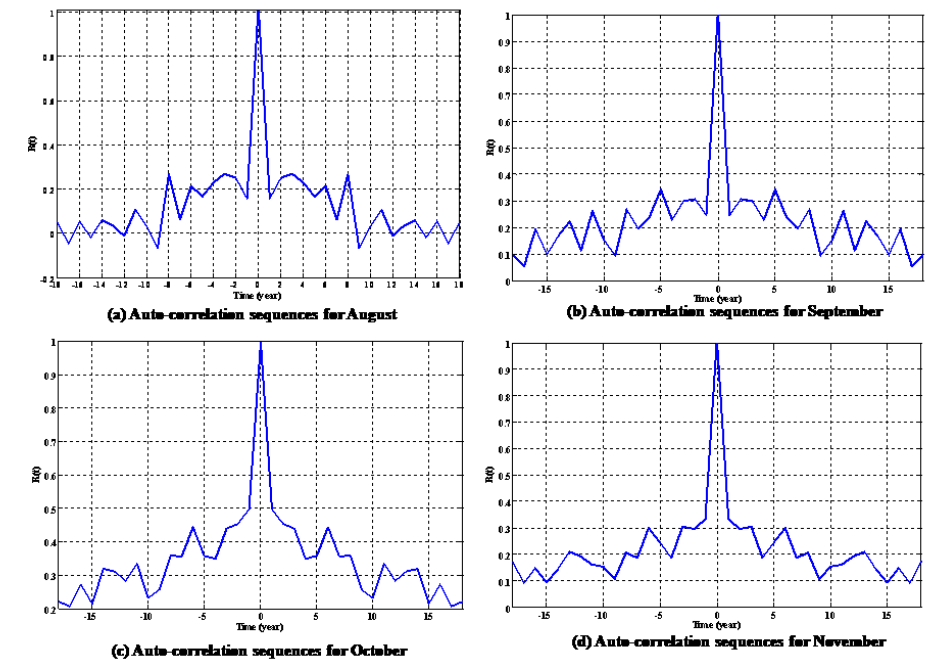
Fig. (2). The auto-correlation sequence for the inflow for months of Fig. 2. The auto-correlation sequence for the inflow for months of(August, September, October,